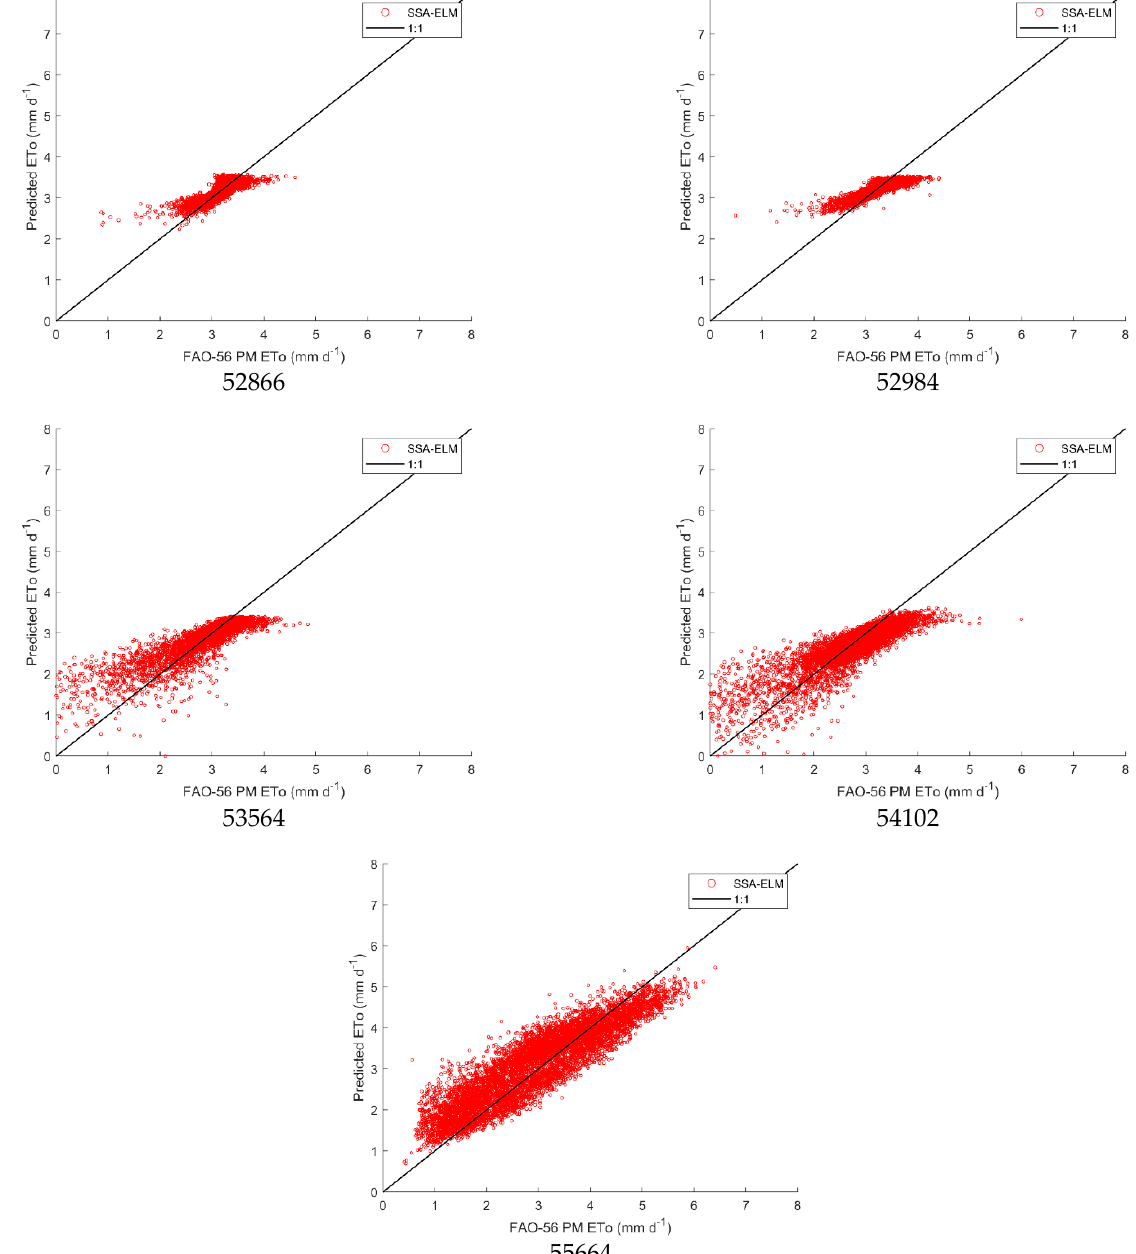
Figure 7. Scatter plots of predicted ET O values using SSA-ELM model against their corresponding FAO56-PM values when entering five factors.